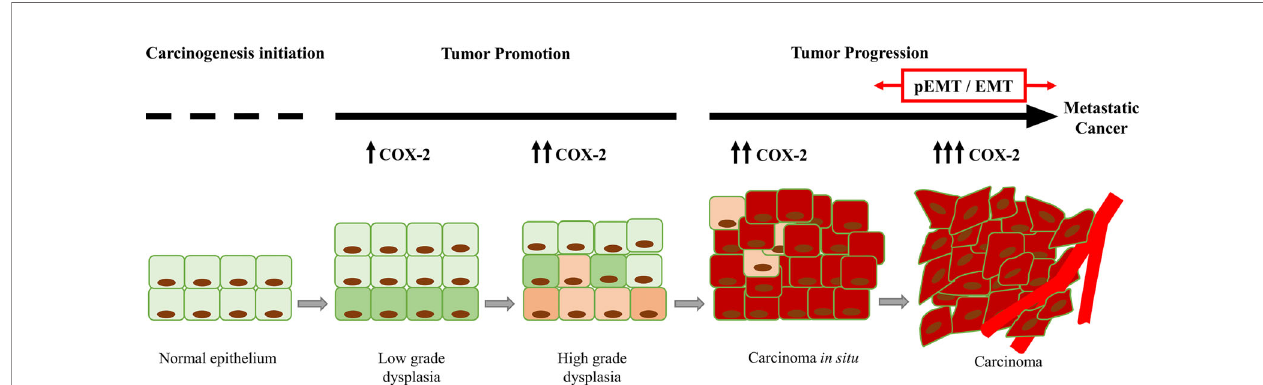
FIGURE 1 | Increase in the COX-2 expression during tumor progression. COX-2 favors tumor progression from the initial stages of tumor promotion (dysplasia). In advanced stages of tumor progression (carcinoma), COX-2 is overexpressed, and it is associated with partial EMT (pEMT) and